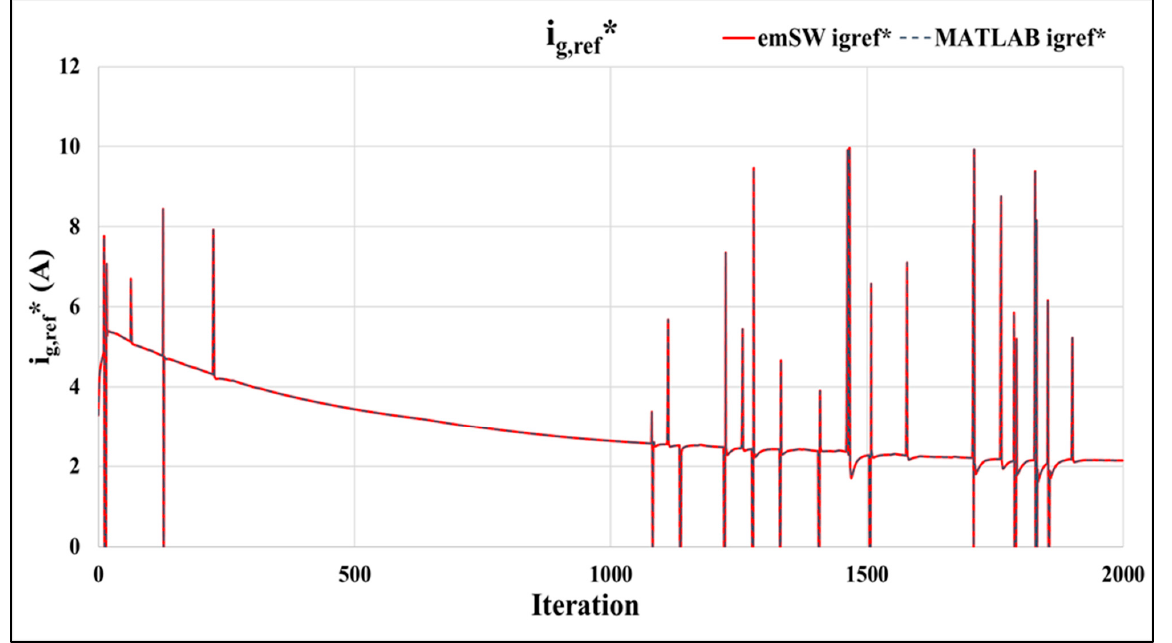
Figure 4. Control signals I gref : proposed embedded software vs. baseline Matlab.